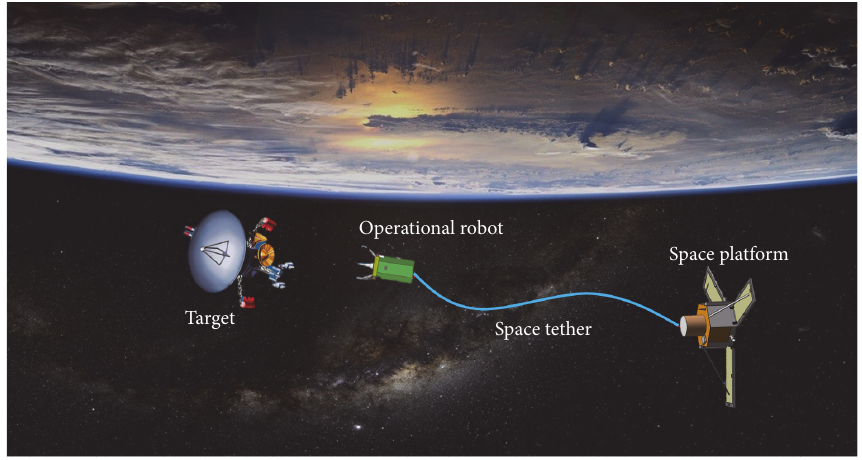
Figure 1: Diagram of tethered space